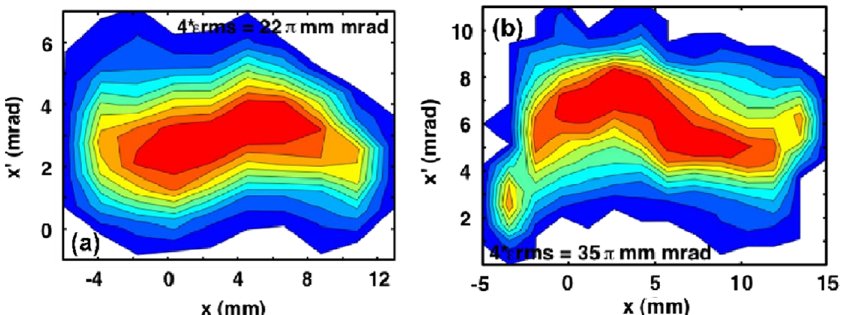
FIG. 14. (Color) Sheared phase space distribution of the unapertured 45-mA beam integrated over a 500 ns gate in the middle of the 10 (cid:1) s beam pulse: (a) 40 cm downstream of the exit of two solenoids ( z (cid:5) 171 cm ); (b) 40 cm downstream of the exit of four solenoids ( z (cid:5) 290 cm ; note scale differences).